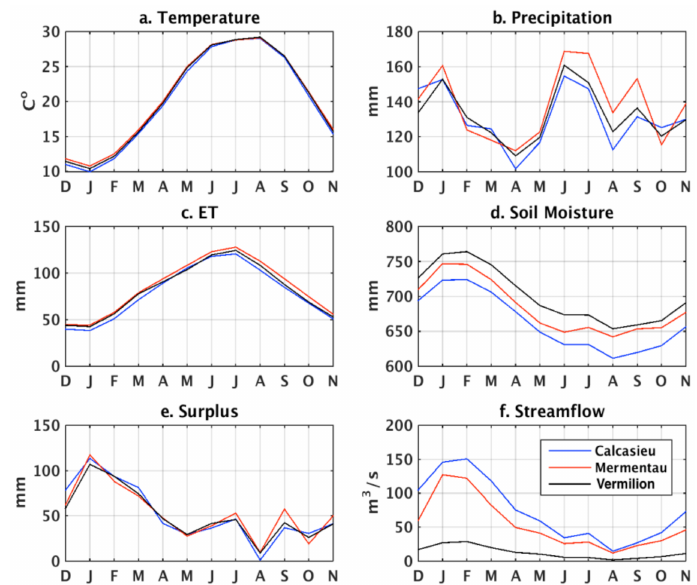
Figure 8. Monthly ( a ) temperature, and ( b ) precipitation from NLDAS-2, and model simulated monthly ( c ) evapotranspiration, ( d ) soil moisture, ( e ) water surplus, and ( f ) streamflow for the Calcasieu (blue), Mermentau (red), and Vermilion (black)